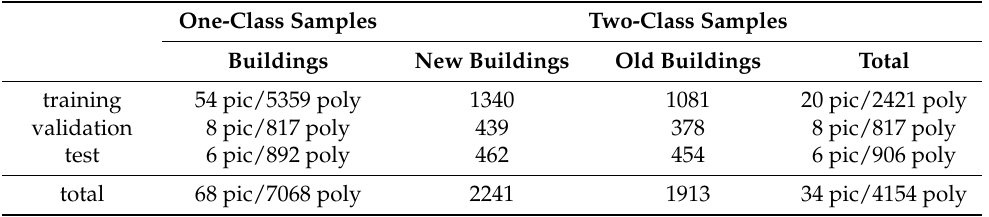
Figure 2. The construction of image dataset. ( a ) a village image; ( b ) the building labels; ( c ) the label json file; ( d ) the mask with building categories. Table 2. The training, validation, and test dataset.